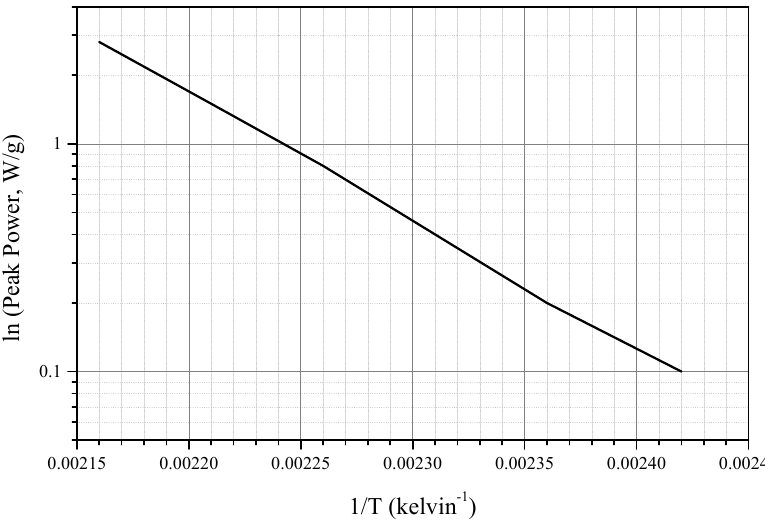
Figure 4. Arrhenius plot of peak power vs. 1/T of ABS powder containing 60%